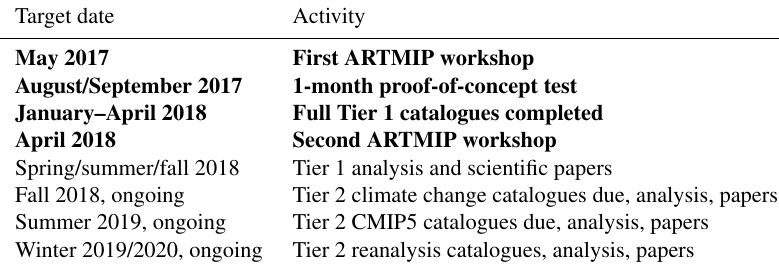
Table 2. ARTMIP timeline. Completed targets are in bold.